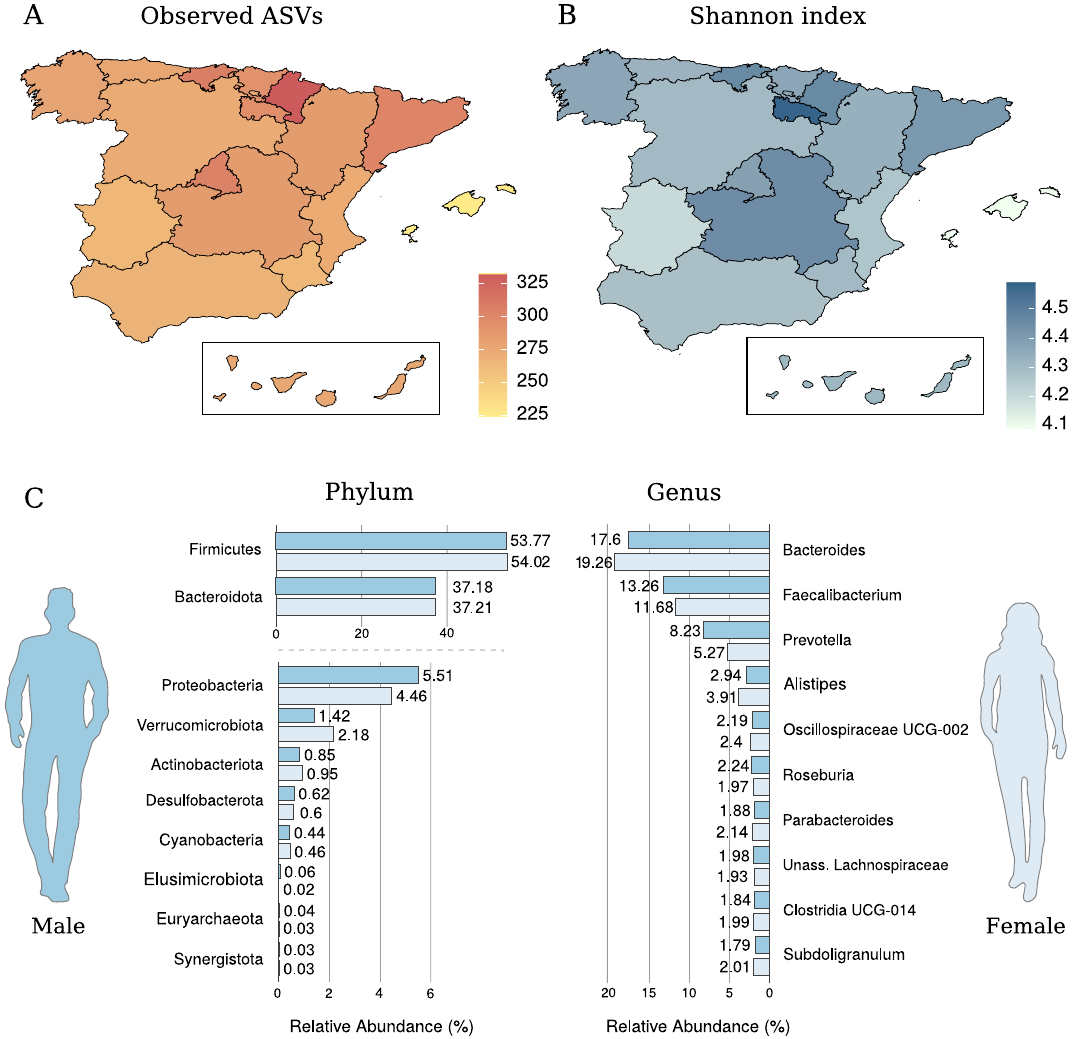
Figure 1. Diversity indices ( A : Richness or Observed ASVs; B : Shannon) across the Spanish territory and ( C ) distribution of the main taxa (phylum and genus level) in the gut microbiome of male and female individuals. Maps were created with rdgal (v. 1.5-16; https:// cran.r- proje ct. org/ web/ packa ges/ rgdal/ index. html) and ggplot2 (v. 3.3.1; https:// ggplo t2. tidyv erse.